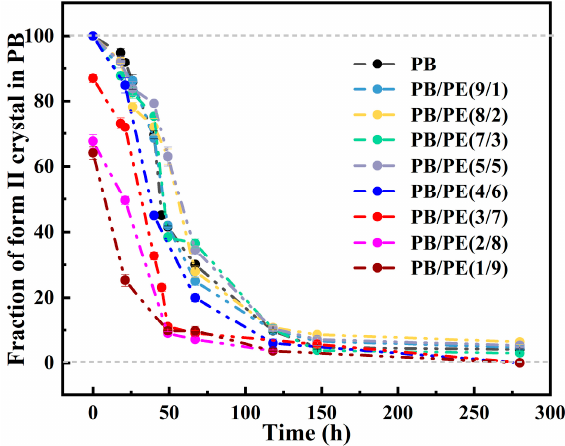
Figure 9. The evolution of form II fractions in total PB crystallites during aging at 25 °C.